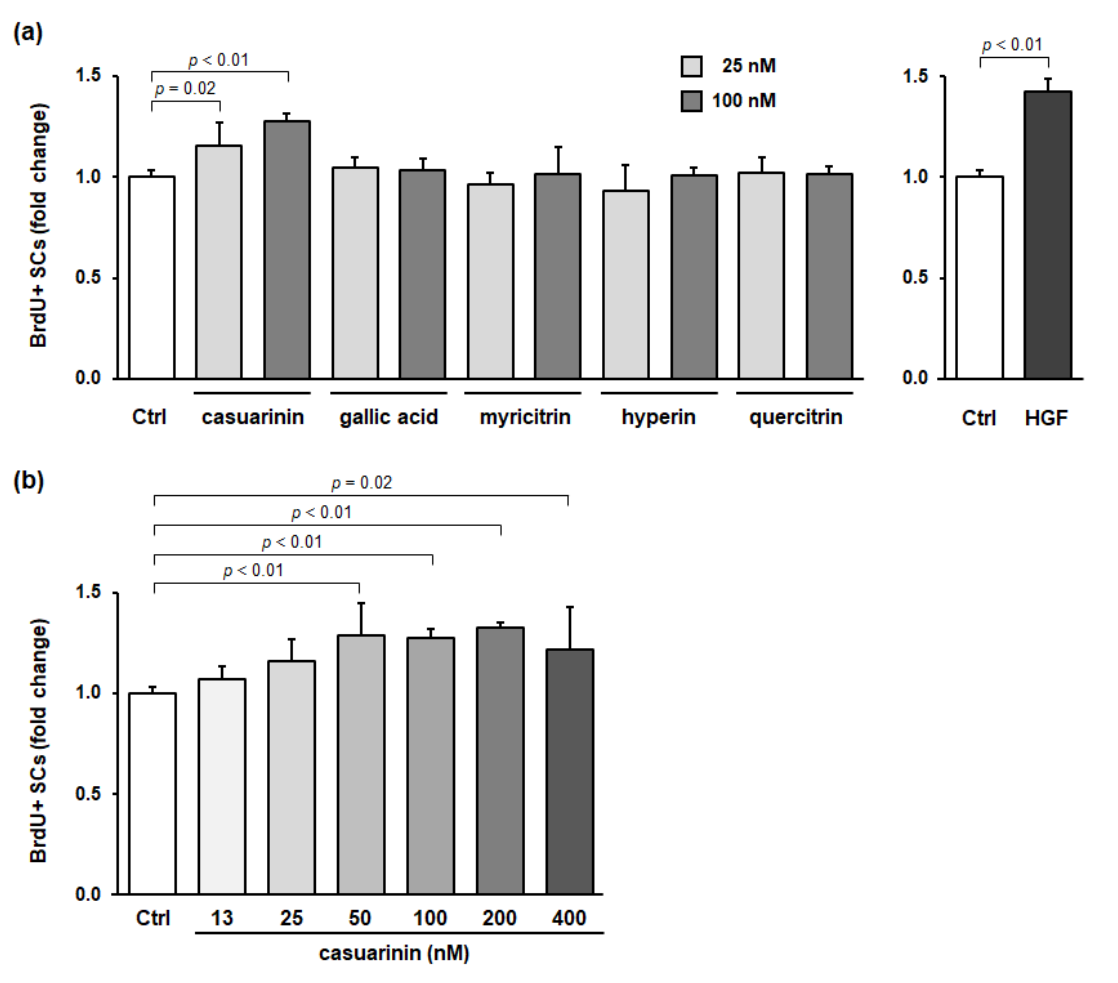
Figure 3. Casuarinin promotes BrdU incorporation into SCs in vitro. ( a ) Effects of the major com- pounds identified in LM on BrdU incorporation into SCs. ( b ) Effects of casuarinin concentration on BrdU incorporation into SCs. The concentration of each sample (except for HGF) is indicated in the figure. The HGF concentration used was 5 ng/mL. BrdU incorporation into SCs is expressed as BrdU + SCs per total SCs and is shown as a fold change compared to the Ctrl. Data represent the mean ± SD of three independent cultures, except for Ctrl and HGF (nine independent cultures). Significant differences ( p < 0.05) relative to the Ctrl are indicated in the figure, and non-significant differences ( p > 0.05) are not shown in the figure.